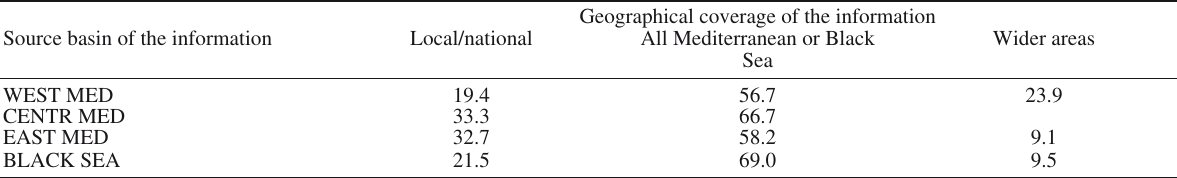
Table 3. – Classification of the information gathered according to the geographical areas covered by each activity. The values reported are the percentage contributions. The results are presented by main basins. Geographical coverage of the information Source basin of the information